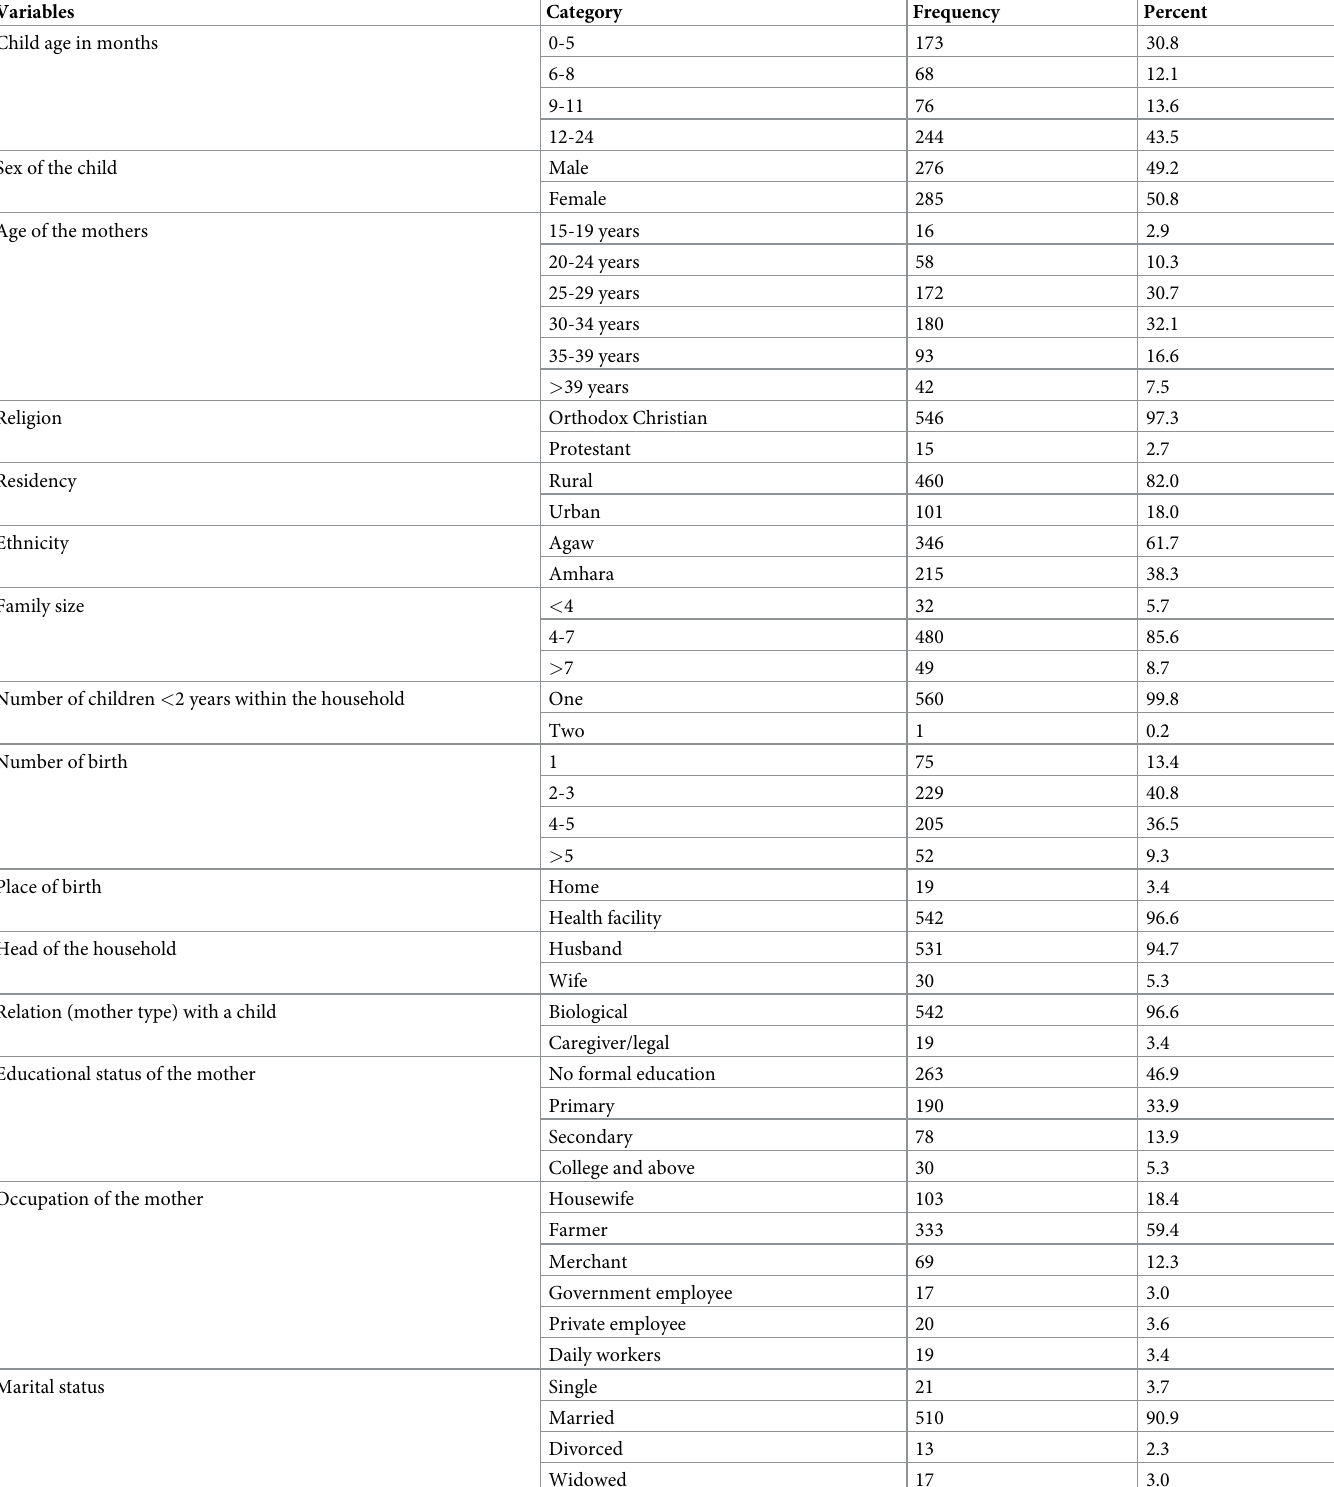
Table 2. Socio-demographic characteristics of the study participants in Banja District, Northwest Ethiopia, 2020 (n =